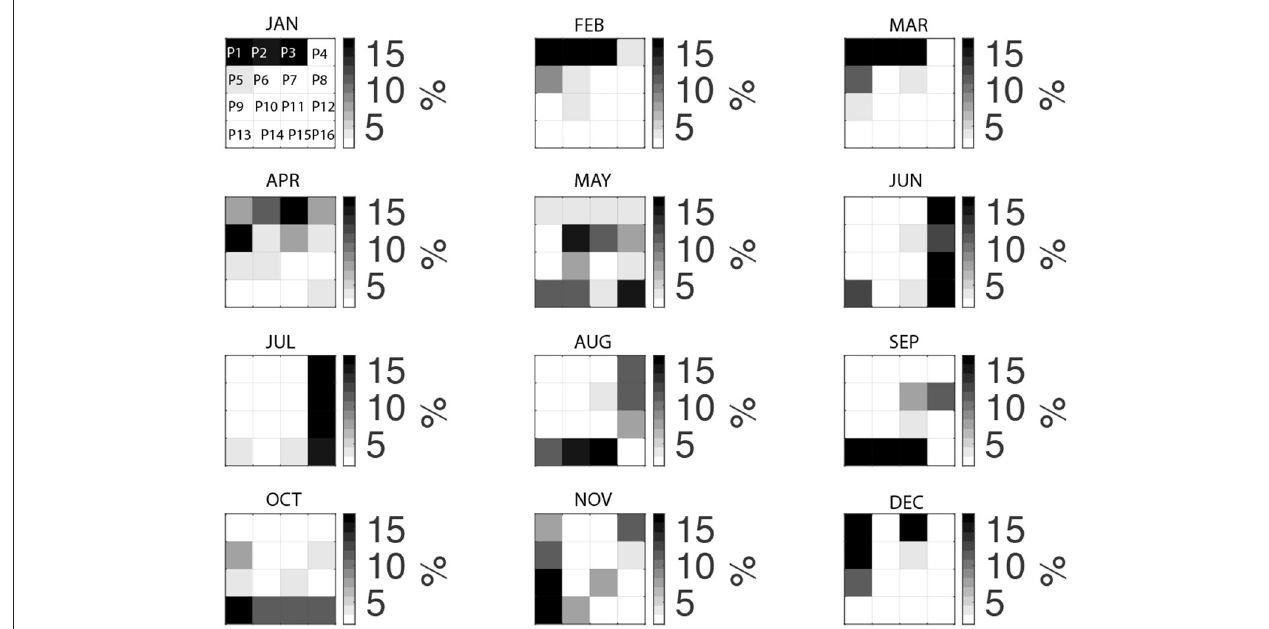
FIGURE 10 | Monthly BMU distribution of SOM patterns for surface currents and